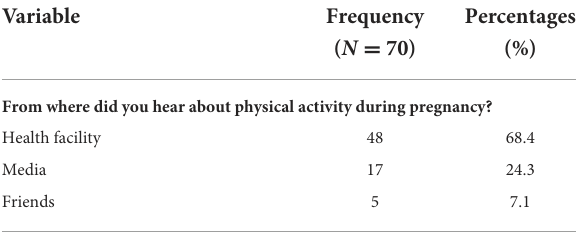
TABLE 5 Correlation analysis between knowledge of PA and level of participation of PA in pregnant women.